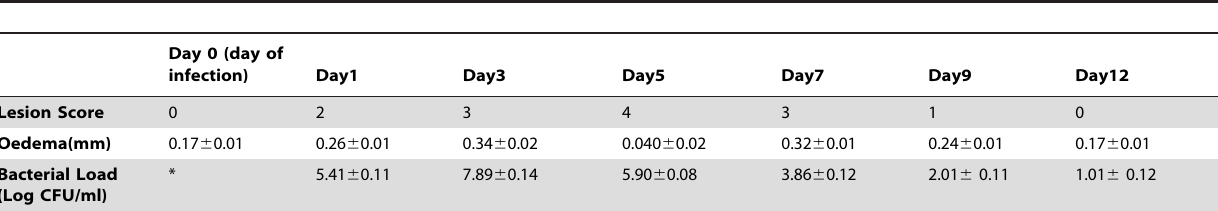
Table 1. Lesion score, oedema levels (mm) and bacterial load in S.aureus infected hindpaw (10 6 CFU/ml) of mice on different days post